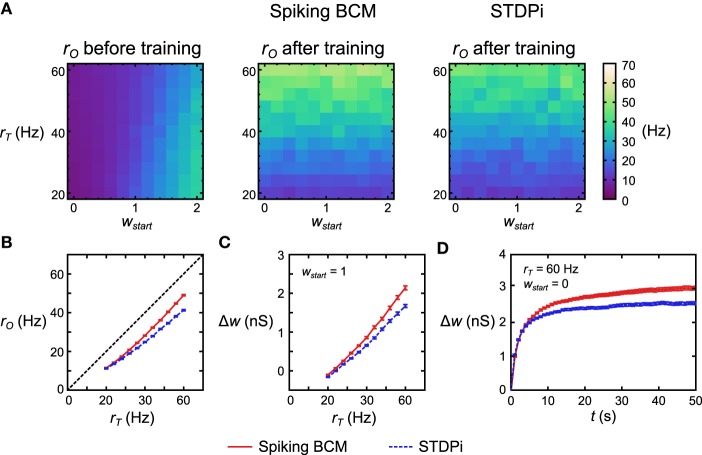
Performance of the delta rule neuronal network. (A) For each plasticity rule, 121 structurally identical networks were given different rT and initial weights wstart. The networks were then simulated for 50 s. Before training rO follows wstart and is largely independent of rT. After training rO follows rT (more accurately, it follows w which has been trained by rT as rO is largely independent of rT on short time scales). (B) Averaging across 50 instantiations of the above 121 delta rule networks and collapsing along the wstart axis, the deviation from rT is nearly constant for all values of rT when Spiking BCM is used (red solid), but it is non-constant when STDPi is used (blue dashed). (C) Networks that use STDPi have trouble attaining high weights. (D) Change in weight over time for one trial of 50 networks. For both plasticity rules the weights approach a certain steady state, but for STDPi this final weight value is lower than it is for Spiking BCM. The error bars are SEM.